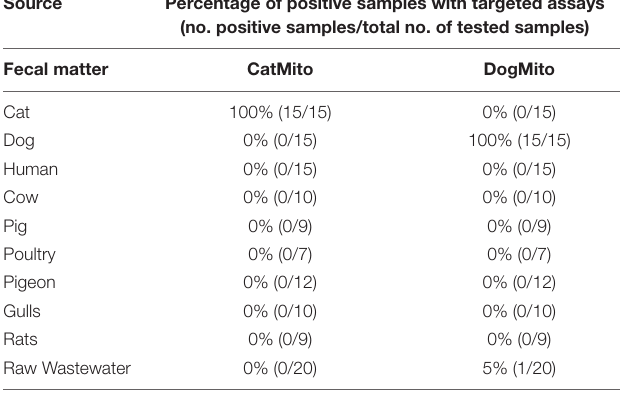
TABLE 3 | Specificity of the cat and dog mtDNA markers in samples from varying fecal origin.